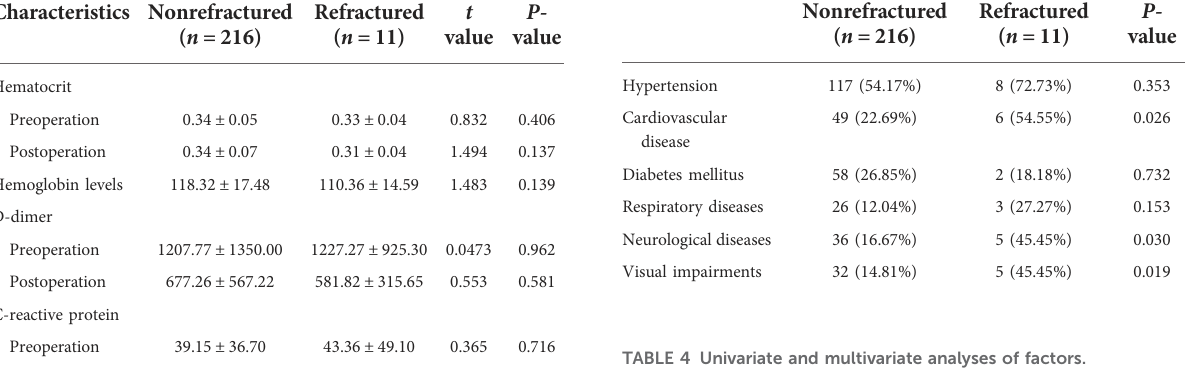
TABLE 3 Comparison of comorbidity between the two groups. TABLE 2 Comparison of laboratory tests between the two groups.